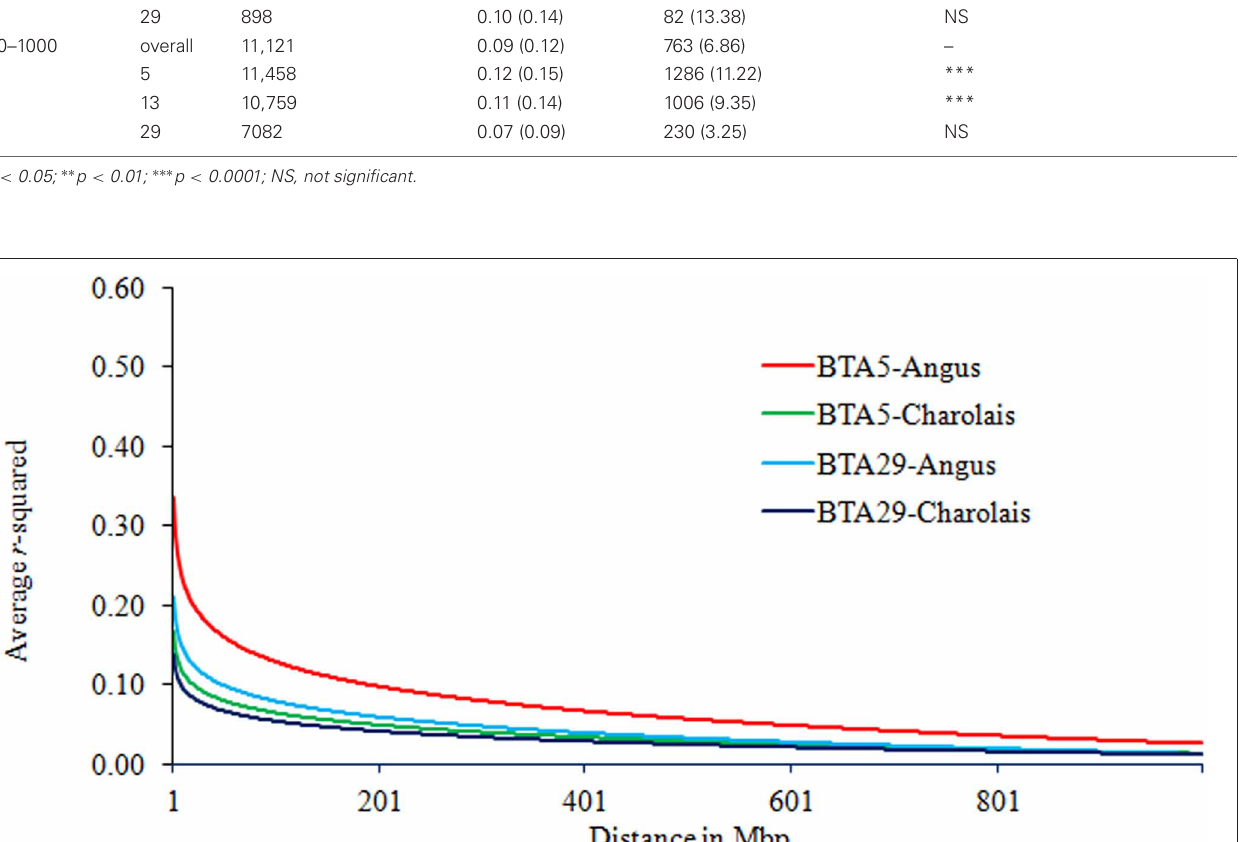
When selection occurs at multiple loci in epistasis, LD between loci under epistatic selection and their tightly linked loci will be created and enhanced (Du et al.,